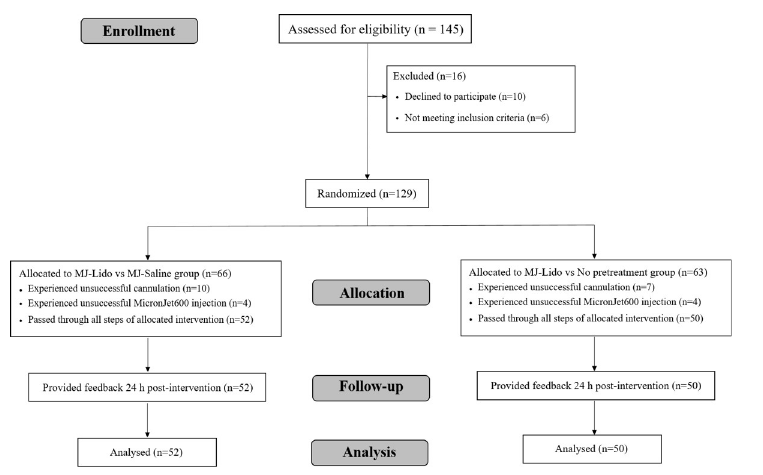
Fig 1. Consolidated standards for reporting of trials